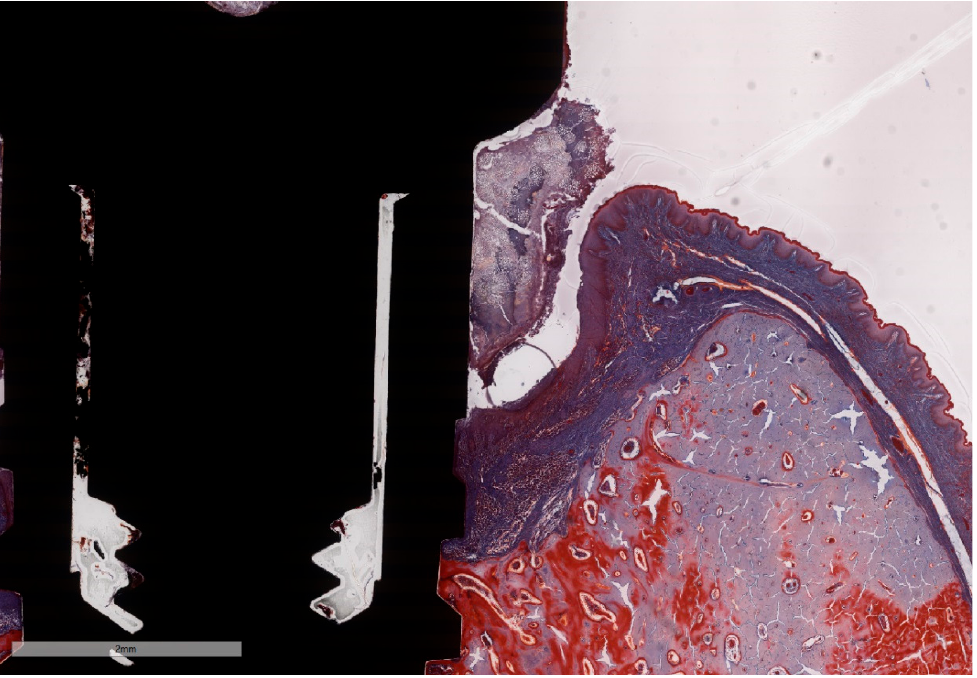
Figure 9. Despite the presence of intense inflammation induced by the ligature, the deep peri-implant sulcus presents a continuous epithelial lining. The intimate contact between the soft tissues and the implant is below the BC level (implant #5, MGA, bar measure is 2 mm).